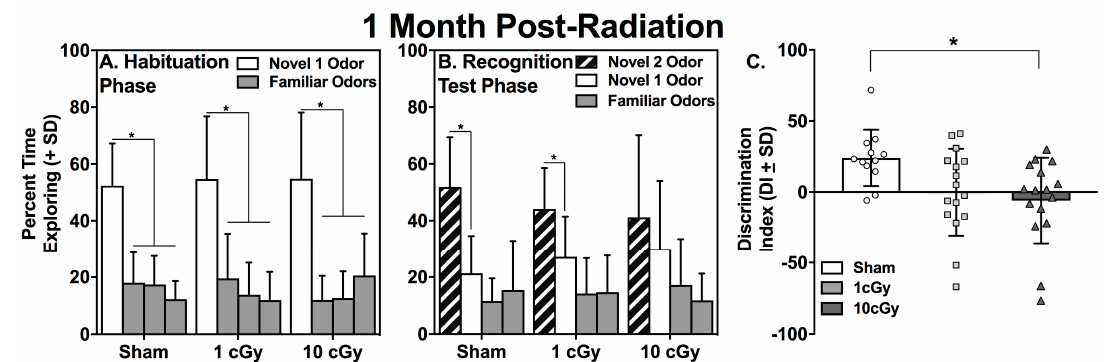
Figure 1. Mean percentage of exploration ( + SD) of novel and familiar odors for sham ( n = 12), 1 cGy ( n = 16), and 10cGy ( n = 16) 16 O ion exposed rats on ( A ) Trial 1 of Habituation and (B) Trial 1 of the Recognition Test, one month following exposure. All rats displayed a significantly greater percentage of exploration of the novel 1 odor on Habituation compared to the familiar odors (* p < 0.05). Sham and 1 cGy-exposed rats displayed significantly greater exploration of the novel 2 odor during the Recognition Test (* p ≤ 0.05). Each group of bars in A and B represents mean percentage of exploration of the four odor-impregnated wooden beads during either Habituation or the Recognition Test. Solid white bars: novel 1 odor. Solid gray bars: familiar odors. Hatched bars: novel 2 odor. ( C ) The 10 cGy-exposed rats displayed a discrimination index significantly less than the sham rats (* p < 0.05); bars represent group averages and symbols represent individual animals. Table 1. Novel 1 odor (N1) exploration during Habituation at one month post-exposure.